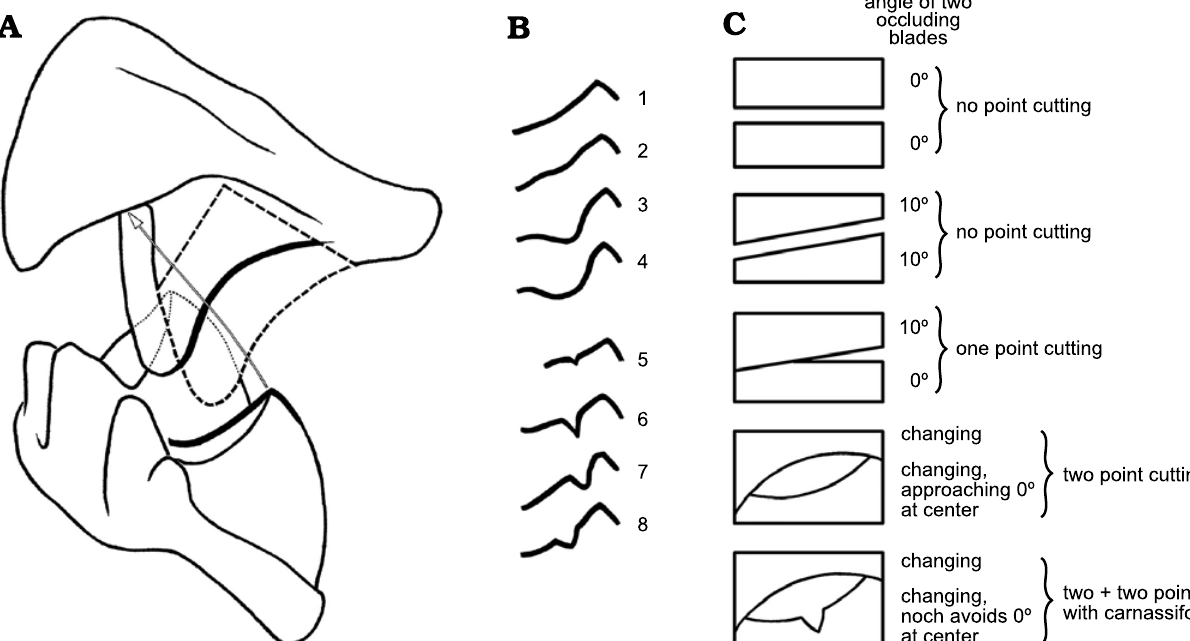
Fig. 14. A . Diagram of a bat M2 and m2 in posterolingual view showing the relationship of the shearing crests (postparacrista of M2 with cristid obliqua of m2) of tribosphenic bat molars during occlusion. Dotted line indicates portion of m2 hidden by M2; dashed line indicates metacone “removed” to re- veal the paracone and postparacrista of M2; thin arrow indicates trajectory of hypoconid into the protofossa (not visible) of M2 during occlusion; boldest line on M2 is edge of postparacrista; boldest line on m2 is tip of hypoconid and cristid obliqua. B . Outline representations of the hypoconid and cristid obliqua observed in this study, without and with in-crest carnassiform notches. Types 1–4 without carnassiform notches: 1 and 2 are seen for example, in Hipposideridae, Rhinolophidae, Rhinopomatidae, Emballonuridae, Mormoopidae, Phyllostomidae, Molossidae, Vespertilionidae; 3 in